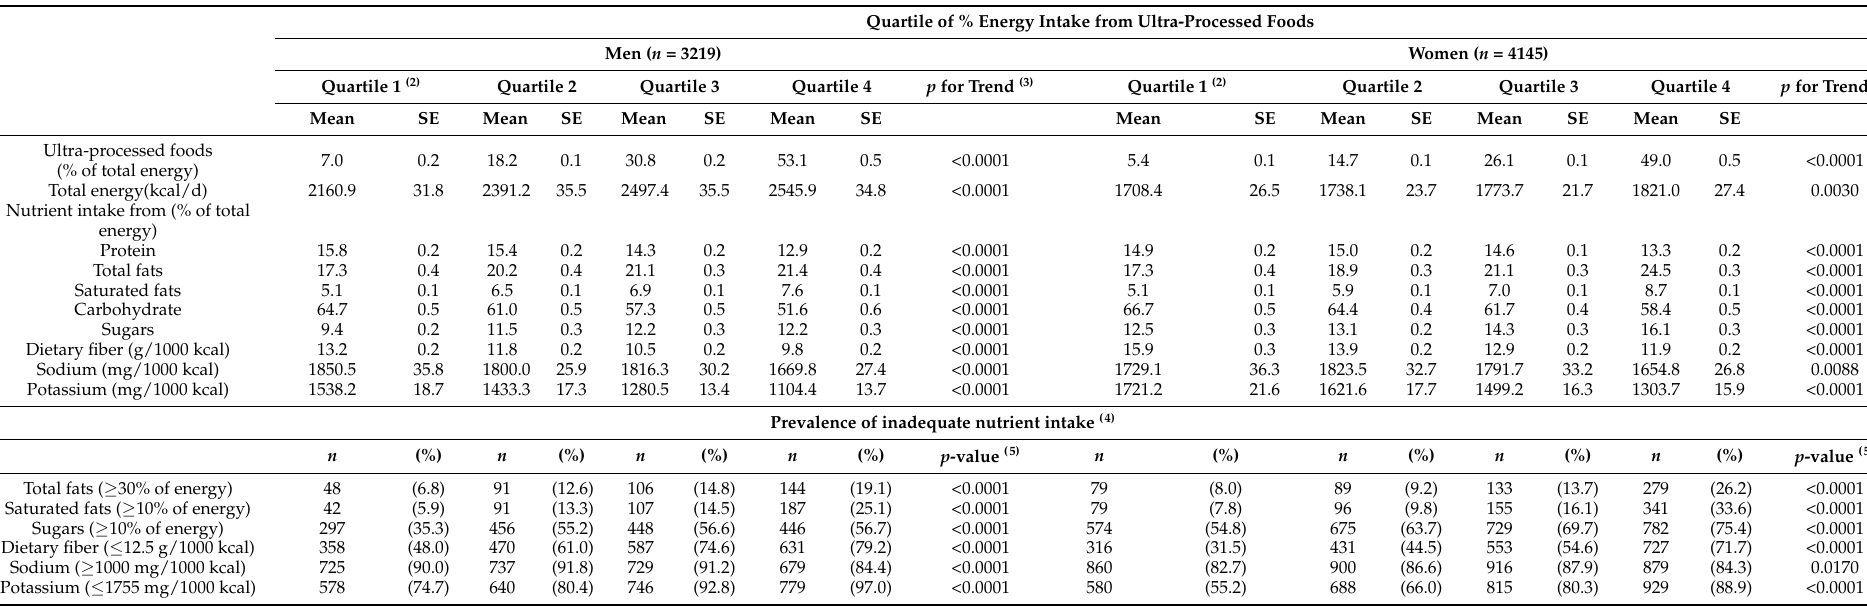
Table 3. Nutrient intakes and prevalence of inadequate nutrient intake according to quartiles of relative energy intake from ultra-processed foods among Korean adults (1)